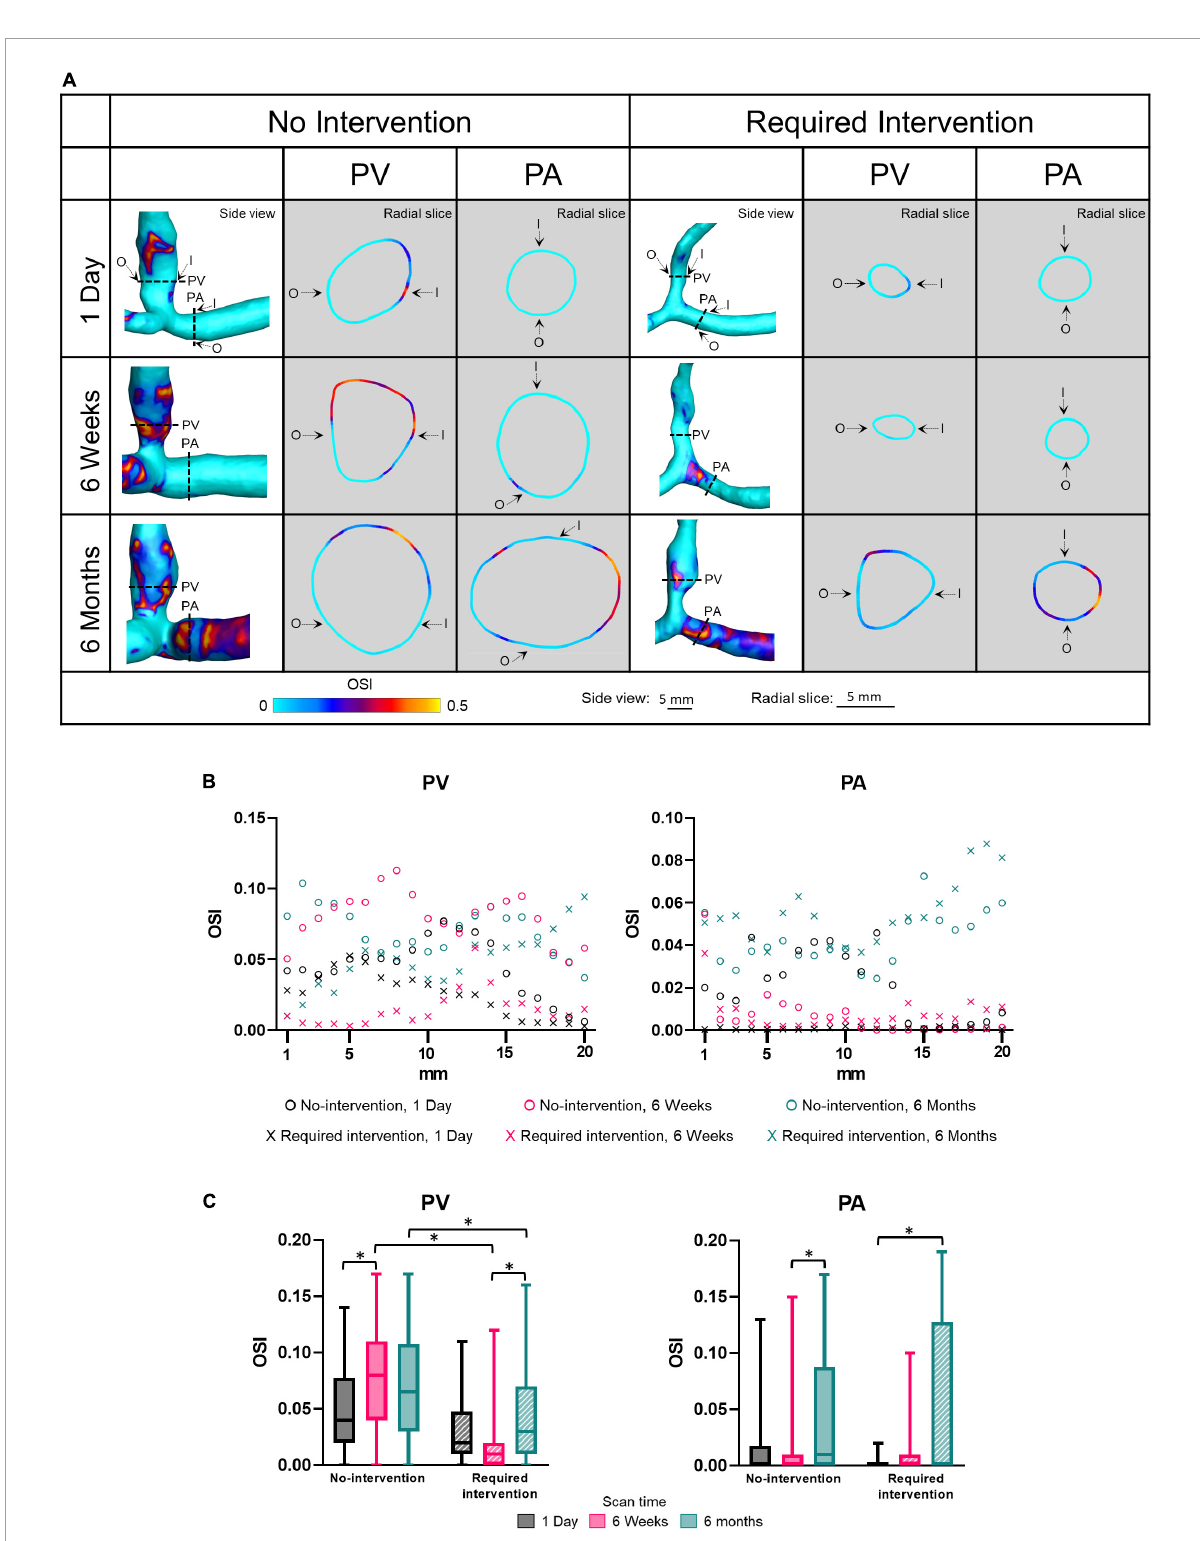
FIGURE5 Oscillatory shear index (OSI) of proximal vein (PV) and proximal artery (PA). (A) The side view and radial slices of OSI color maps of representative arteriovenous fistulas. Dotted lines in the side view color maps show the location of radial slices, approximately 5 mm from the anastomosis. O and I denote the locations of outer and inner walls, respectively. (B,C) Show OSI for the "no intervention" and "required intervention" groups at 1 day, 6 weeks, and 6 months, as explained in Figure 2 . ∗ P <